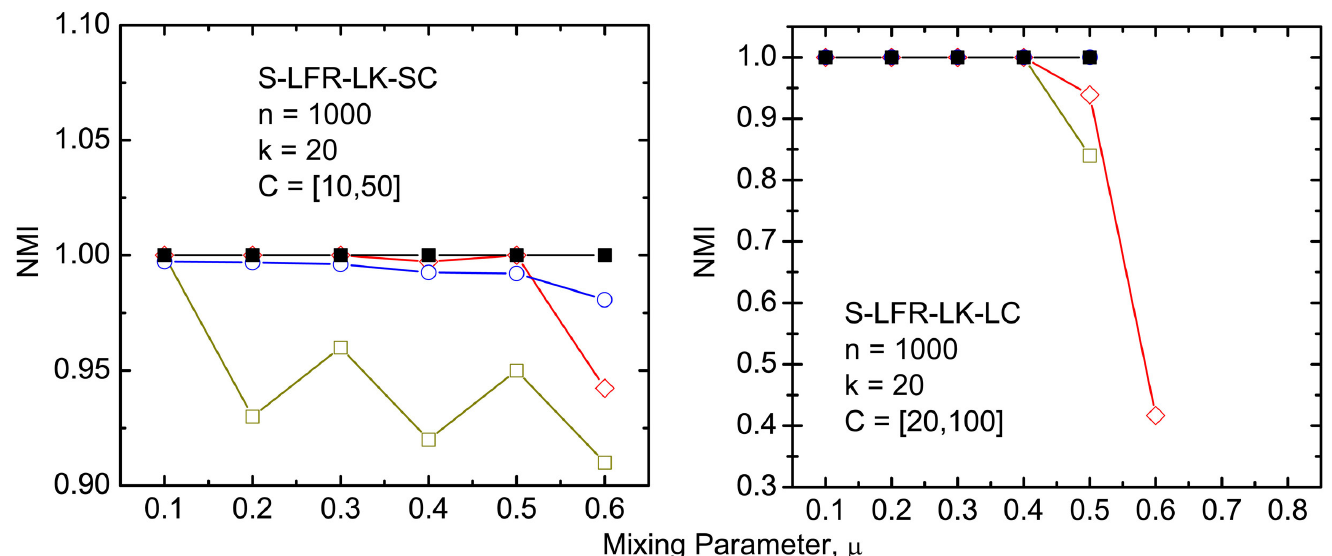
Fig 5. The NMI comparison on undirected and unweighted small LFR benchmark networks with large average degree. The legend is the same as in Fig 4.